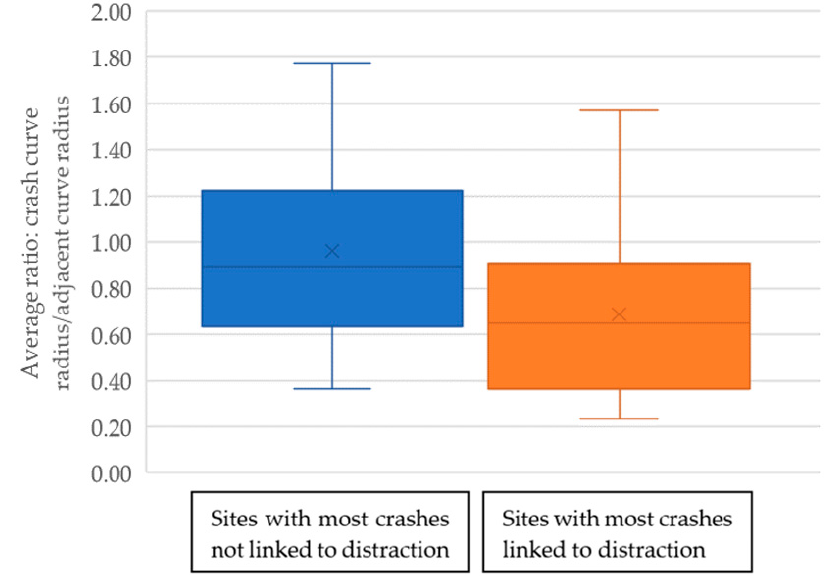
Figure 4. Boxplots of the distribution of crash curve radius to the radius of the adjacent curves’ average ratios for sites with the most crashes linked and not linked to distraction. ratios for sites with the most crashes linked and not linked to